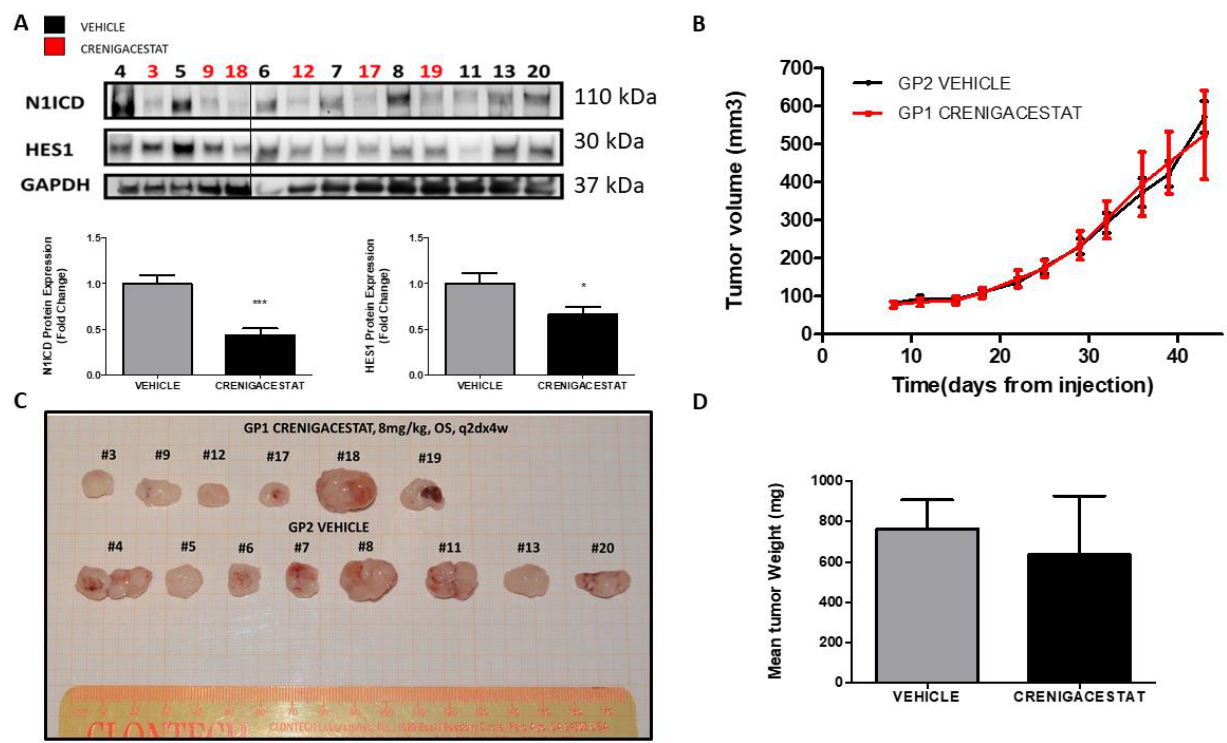
Figure 1. Crenigacestat does not reduce iCCA tumor progression but inhibits Notch1 pathway in the iCCA HuCCT1-xenograft model. ( A ) Western blotting shows significant inhibition of N1ICD (*** p < 0.001) and HES1 (* p < 0.05) expression in treated HuCCT1-xenograft tissues related to GAPDH expression for each respective tissue. The semi-quantitative evaluation by densitometry analysis of protein bands is shown in the graphs, comparing the average value of the levels of N1ICD and HES1 among all the mice treated with Crenigacestat normalized with respect to vehicle. ( B ) Crenigacestat, compared with vehicle, has no effect on tumor progression ( C , D ), nor does it reduce the weight of the iCCA masses in the HuCCT1-xenograft model. Explanted tumor masses of HuCCT1-xenograft mice n = 8 for vehicle treatment, n = 6 for Crenigacestat treatment.